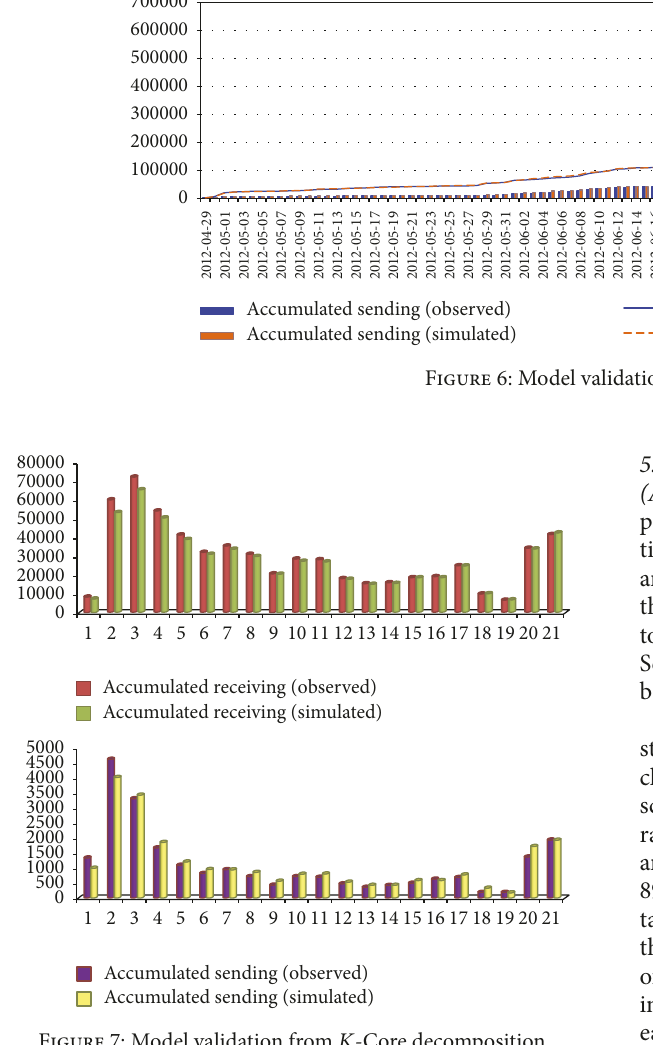
Figure 7: Model validation from 𝐾 -Core